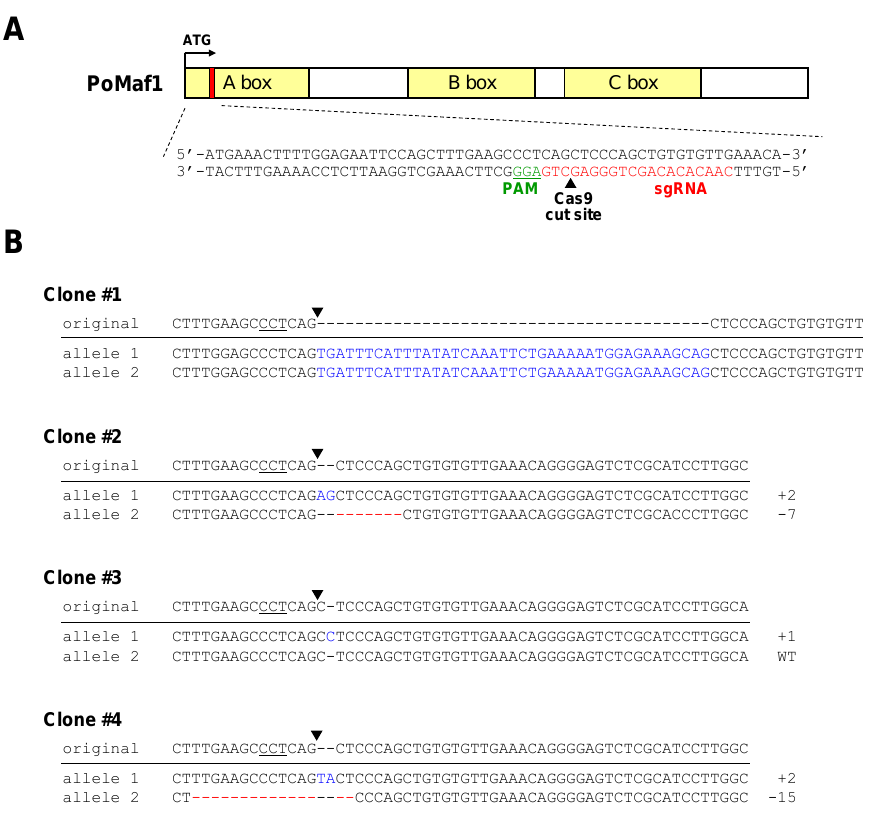
Figure 6. Construction of single cell-derived PoMaf1 knockout (KO) clones using CRISPR/Cas9 system. ( A ) Simplified schematic of the Cas9/sgRNA-targeting site in the PoMaf1 coding region. sgRNA and protospacer-adjacent motif (PAM) sequences are labeled in red and green, respectively. The Cas9 cutting site is indicated by a black arrow. ( B ) Indel sequences of mutant alleles of four single-cell-derived clones are shown compared to the original PoMaf1 sequence. PAM sequences are underlined and the Cas9 cutting site is indicated by a black arrow. Insertions and deletions are indicated in blue and red, respectively. The size of each indel is indicated on the right. Genomic DNA of each clone was extracted and amplified by PCR. TA clones of the PCR products were subjected to Sanger sequencing.